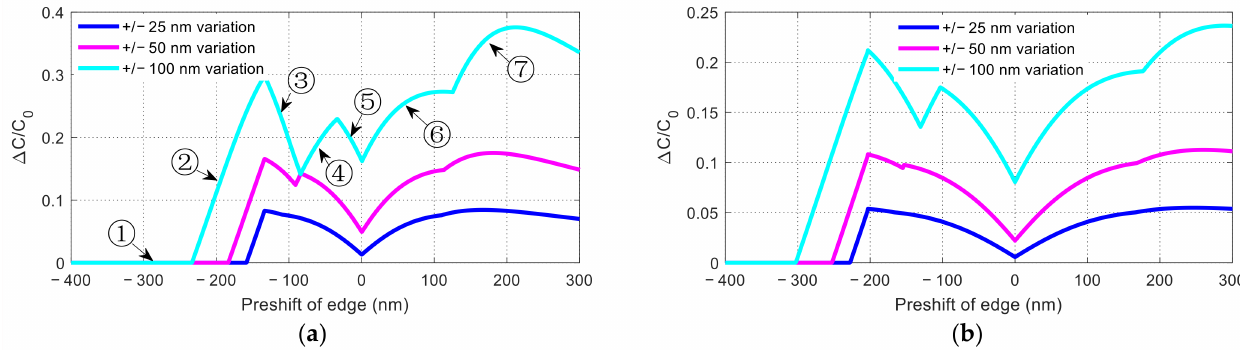
Figure 11. Mitigation of fabrication variation: Junction capacitance affected by the edge shift of the P and N regions caused by fabrication variation for different relative pre-shift of the edges. ( a ) under − 1.7 V bias, ( b ) under − 5 V bias. C 0 = C pn is the original PN junction capacitance with no overlap or gap. Positive pre-shift: P-i-N case. Negative pre-shift: overlap